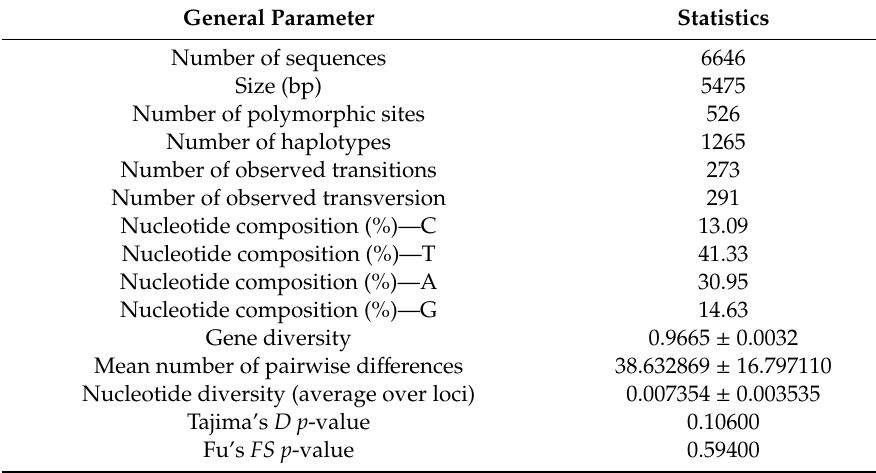
Table 1. General statistics obtained for the final dataset of 6646 Saccharomyces cerevisiae mtDNA genomes using Arlequin and